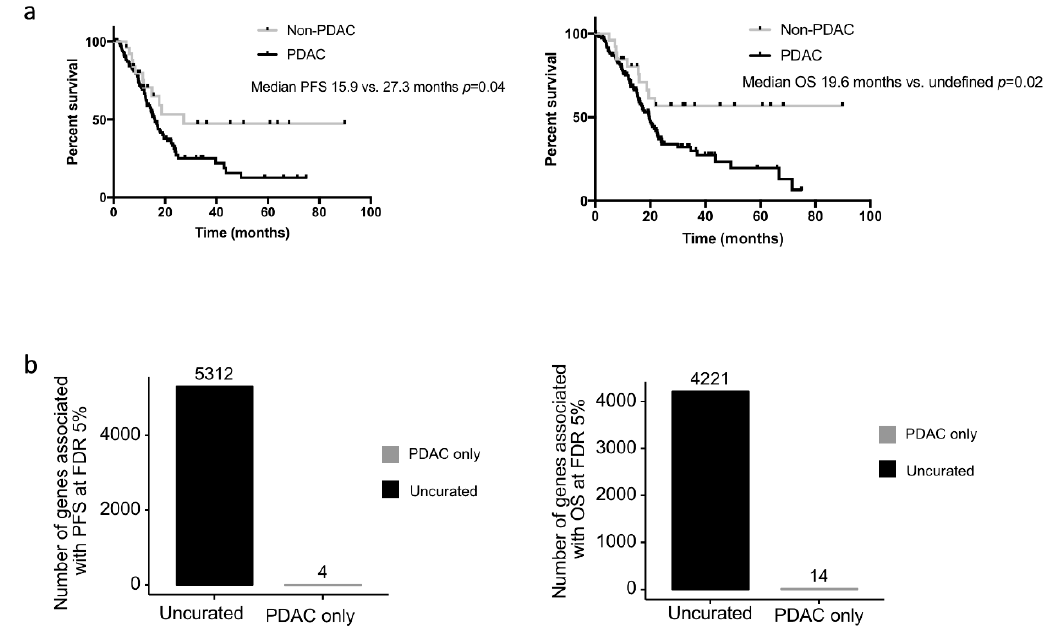
Figure 3. Progression-free and overall survival of the PDAC and non-PDAC cases. ( a ) Kaplan-Meier curves depicting the progression-free (left panel) and overall survival (right panel) of the PDAC cases ( n = 150) and the non-PDAC cases ( n = 27). ( b ) Number of genes associated significantly associated with the progression-free (left panel) and overall survival (right panel) in PDAC only cases and the uncurated